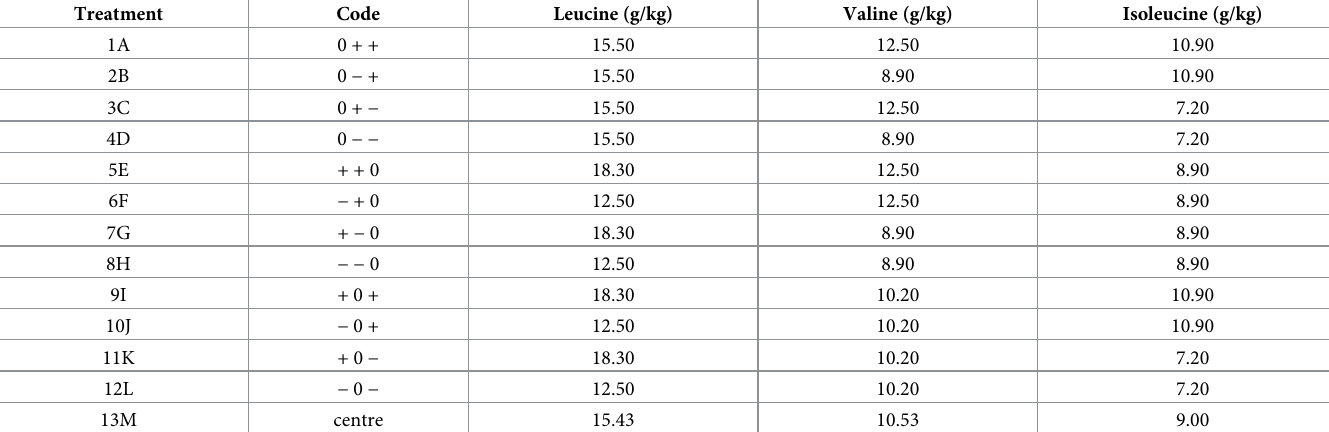
Table 2. List of experimental treatments for Ross 308 off-sex male broiler chickens from 7 to 28 days post-hatch. Treatment